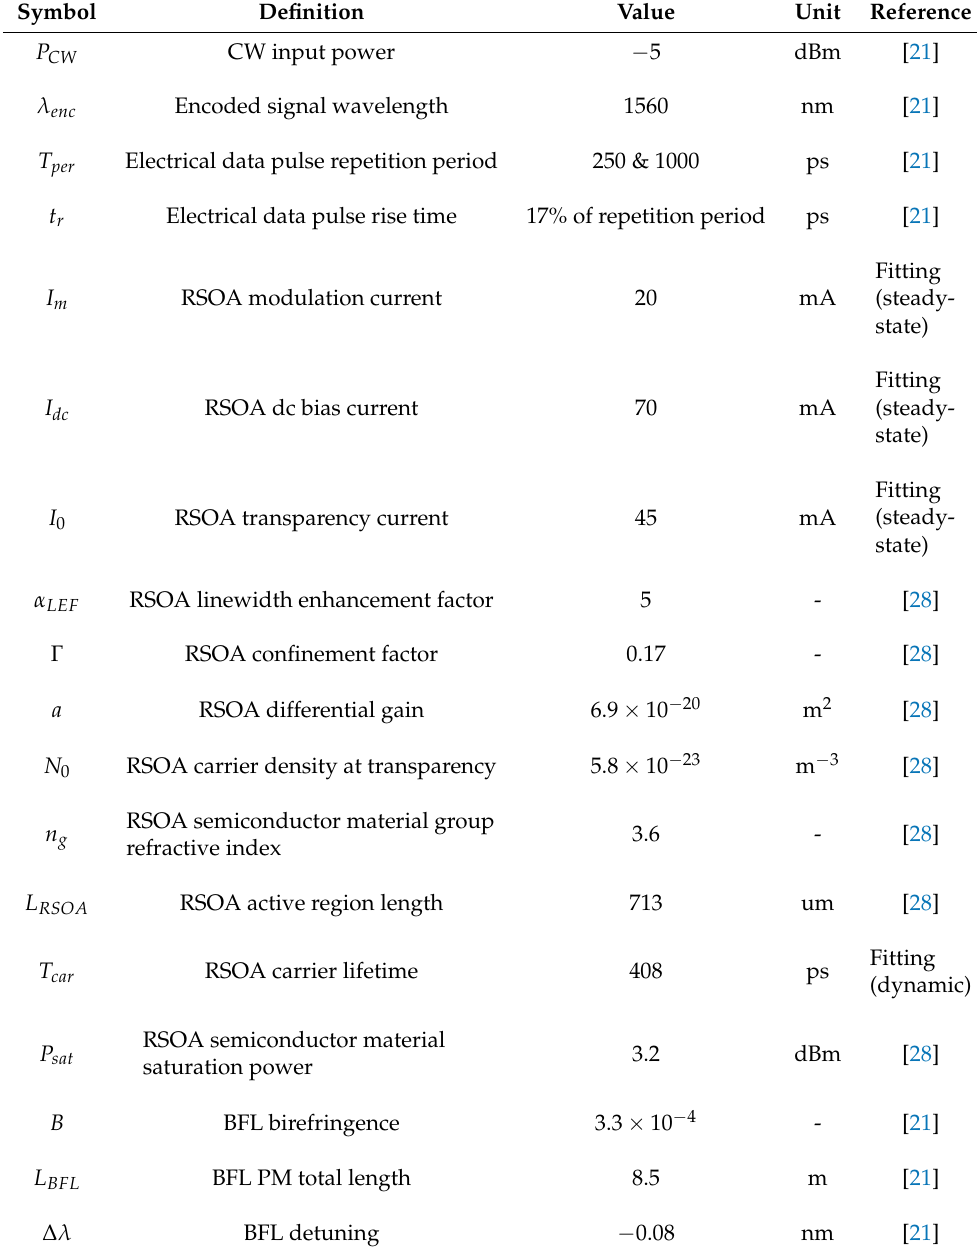
Table 1. Simulation parameters default